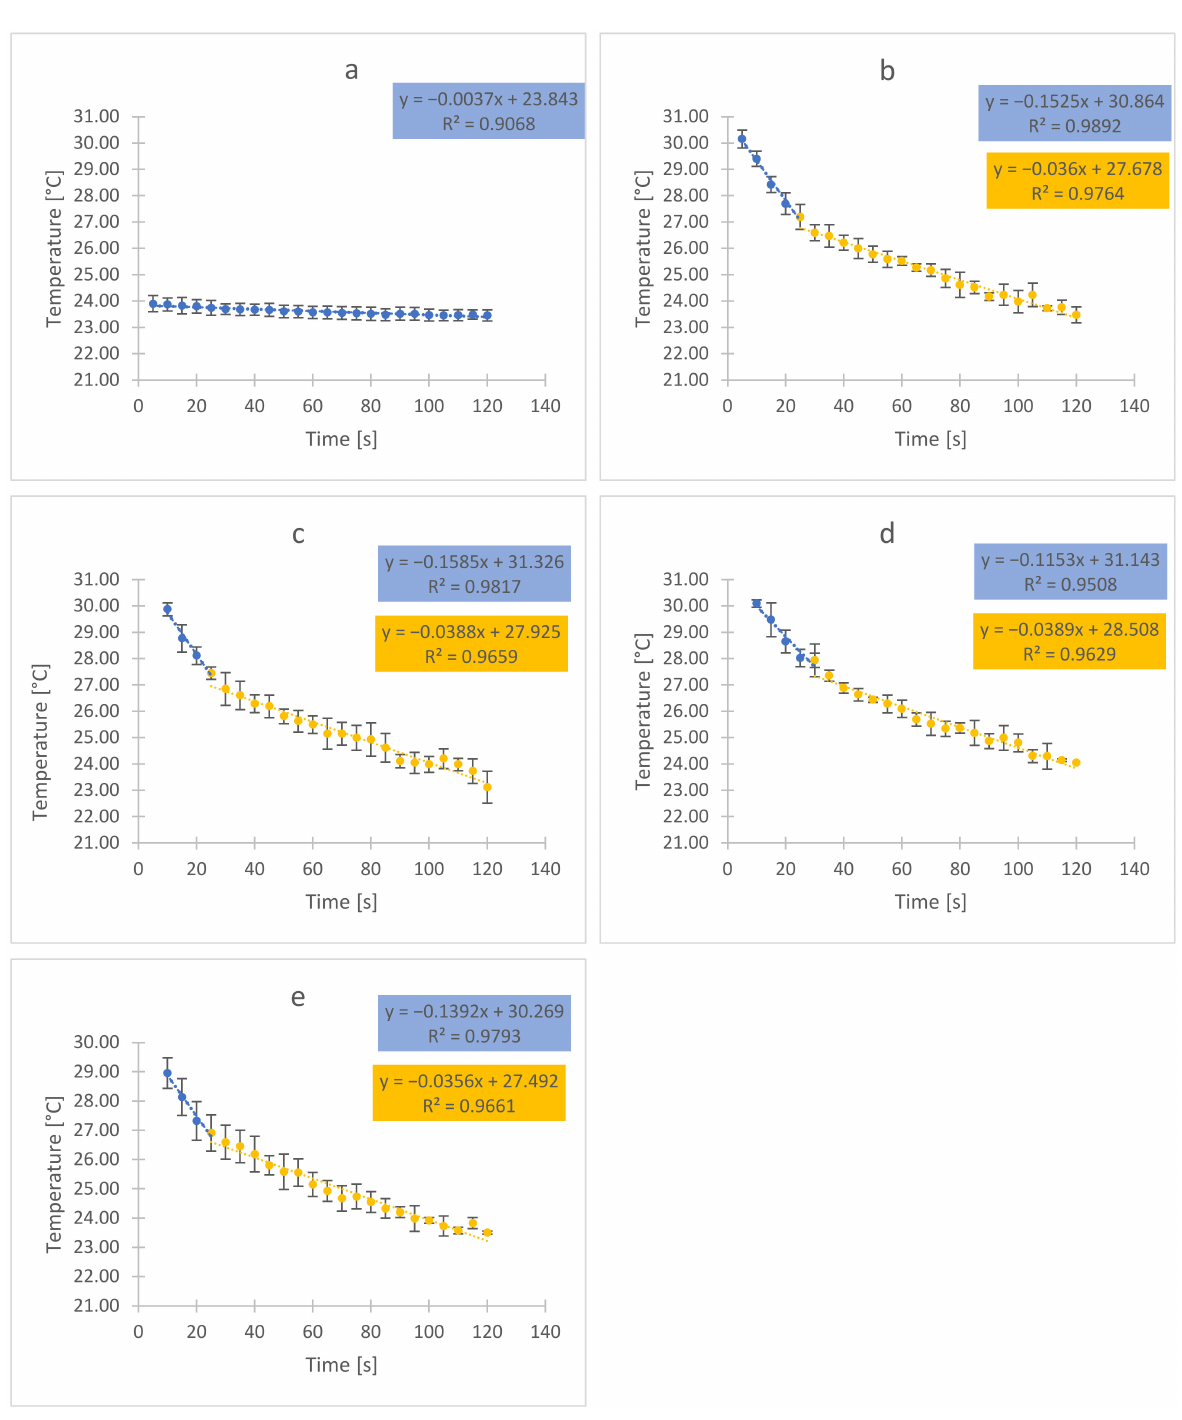
Figure 2. Distribution of temperature changes in mortadella samples after activation (mean val- ues and standard deviation). From the top: Changes in control sample temperatures ( a ) and for samples contaminated with the B. subtilis ATCC 6633 suspension with the following densities: ( b ) 2.2 × 10 9 CFU/g, ( c ) 9.5 × 10 8 CFU/g, ( d ) 5.2 × 10 7 CFU/g, and ( e ) 6.8 × 10 6 CFU/g. The tem- peratures were registered for 2 min every 5 s. Blue represents the trend line for temperature changes between 5 and 25 s and orange represents trend lines between 25 and 120 s of the